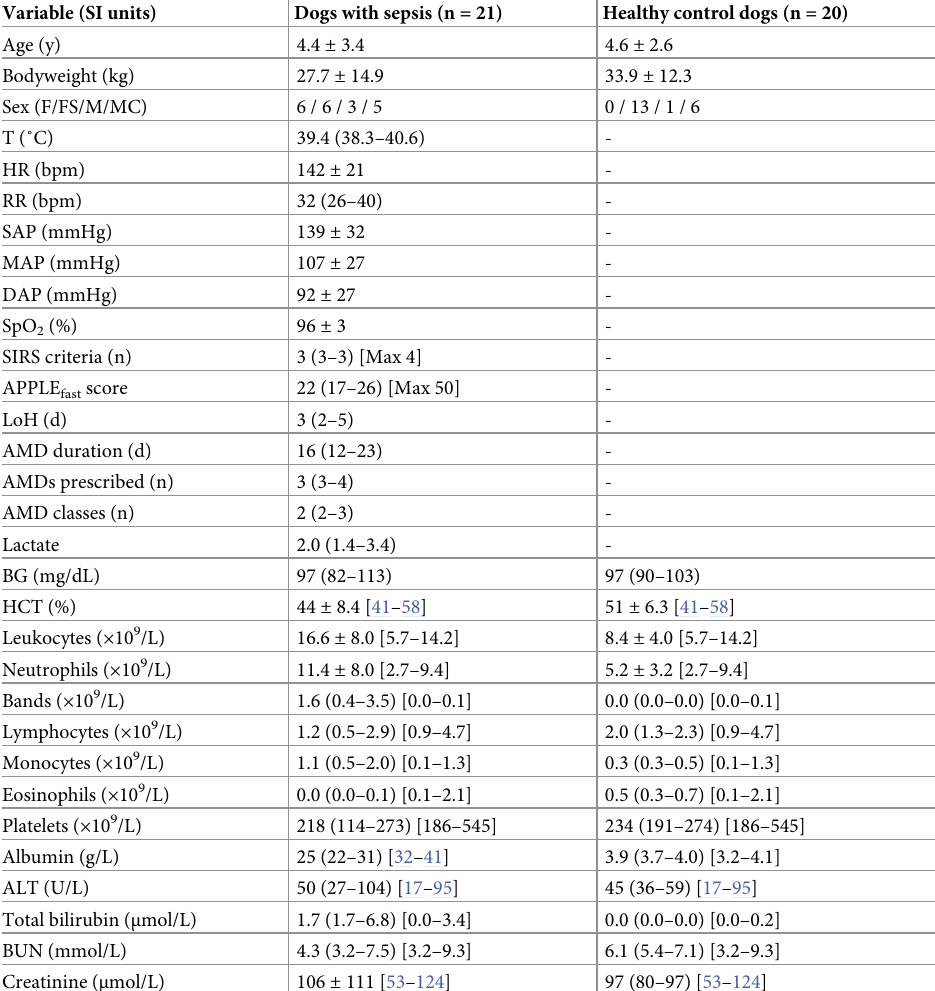
Table 1. Summary of population characteristics including complete blood count and serum biochemistry data from study entry. Variable (SI units)